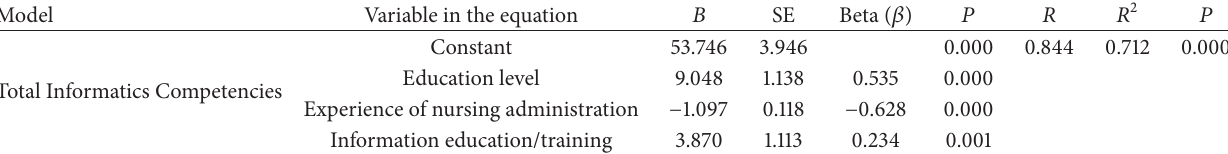
Table 3: Multiple linear regression analysis of predicted variable on informatics competencies (stepwise).